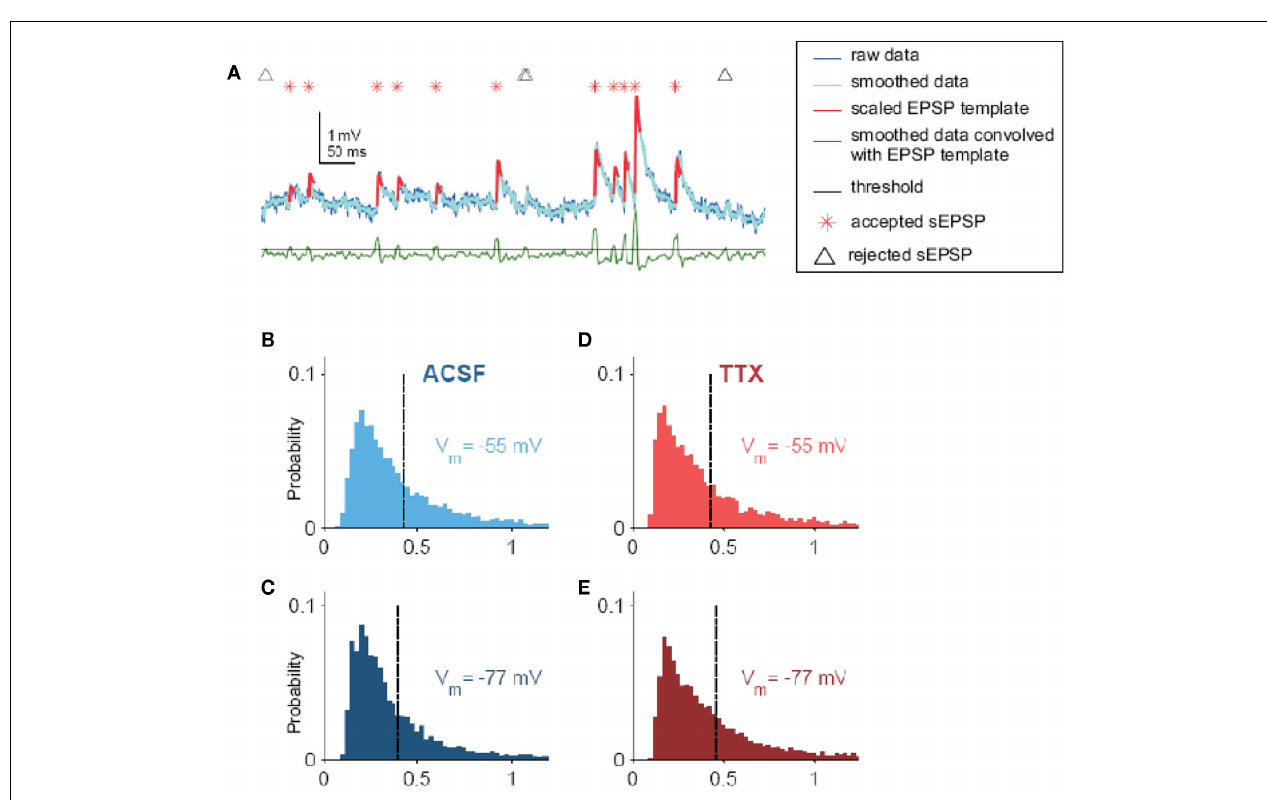
the data in red). Locations of events too small to be confirmed as sEPSPs are noted by black triangles. Convolution and amplitude thresholds were adjusted for each cell by hand. (B) Distribution of sEPSP amplitudes for V m =− 55mV in ACSF (0.43 ± 0.004mV, N = 5855 sEPSPs from 19 cells). (C) Distribution of sEPSP amplitudes for V m =− 77mV in ACSF (0.40 ± 0.004mV, N = 8145 sEPSPs from 19 cells). (D) Distribution of sEPSP amplitudes for V m =−